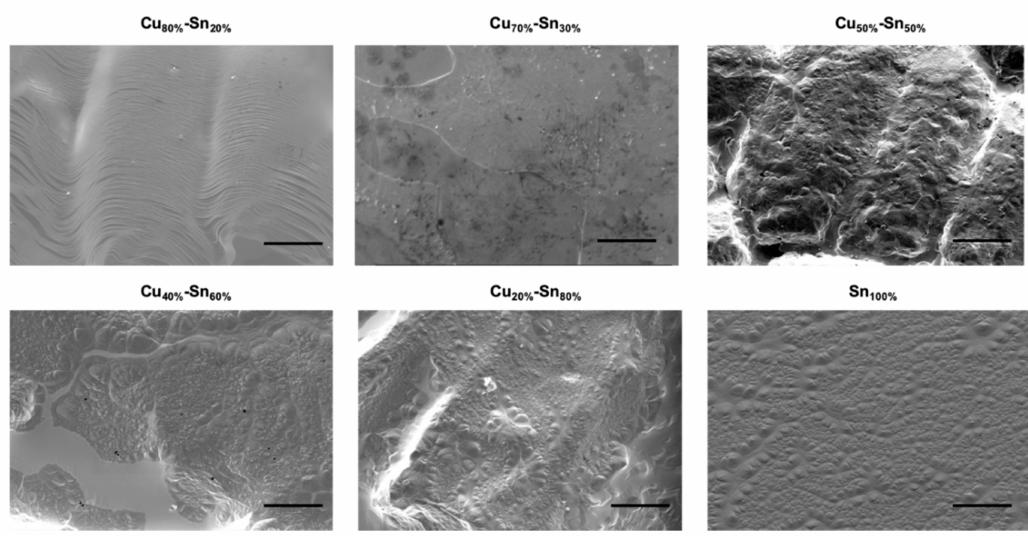
Figure 8. SEM images of Cu–Sn alloys at di ff erent compositions after APCVD graphene growth (Scale bar: 20 µ